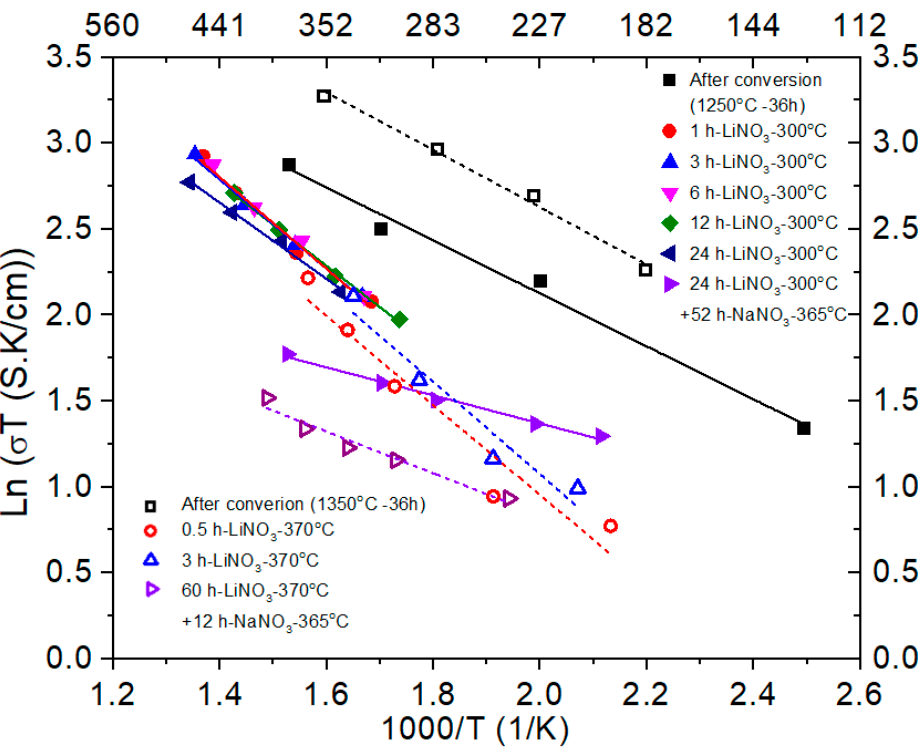
Figure 7. Arrhenius plots of the measured conductivity of the as fabricated samples and after successive lithium ion exchange and after reverse exchange in NaNO 3 .